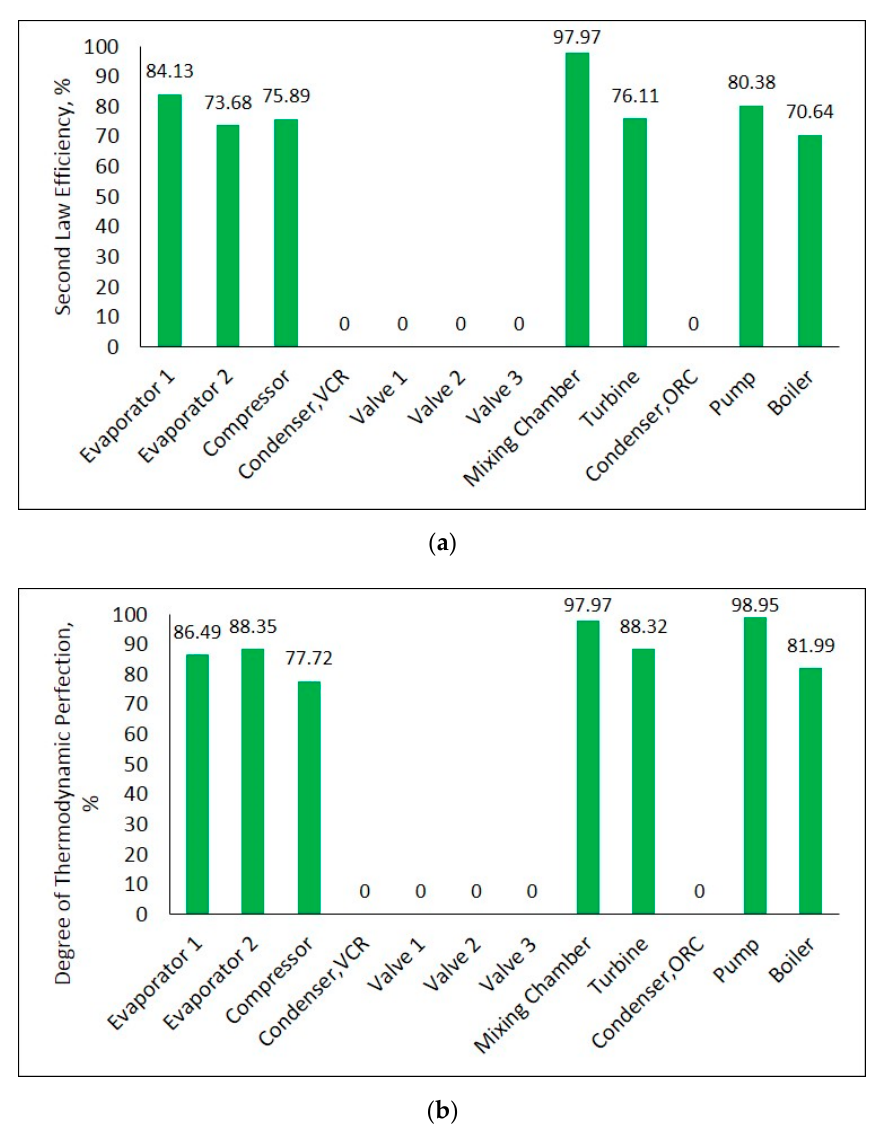
Figure 18. Second law efficiency ( a ) and degree of thermodynamic perfection ( b ) for each component in combined ORC-dual evaporator VCR cycle.